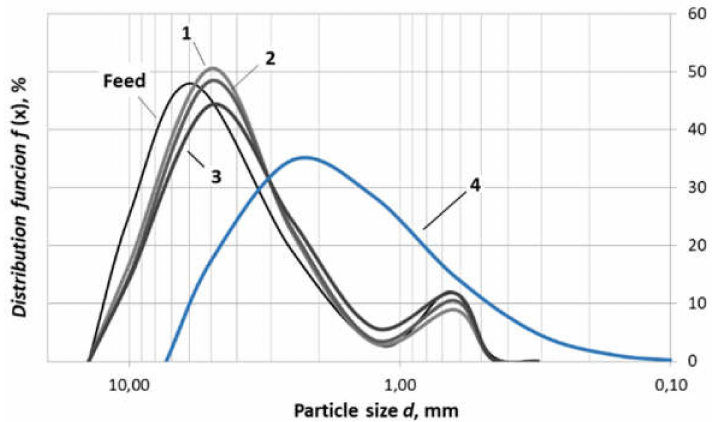
Figure 11. Dependence of the granularity of ground rubber particles on the specific energy of treatment. Grinding at normal temperature with energy. (1) 30 kJ kg − 1 ; (2) 60 kJ kg − 1 ; (3) 90 kJ kg − 1 ; (4) Cryogenic grinding with energy 32 kJ kg − 1 .